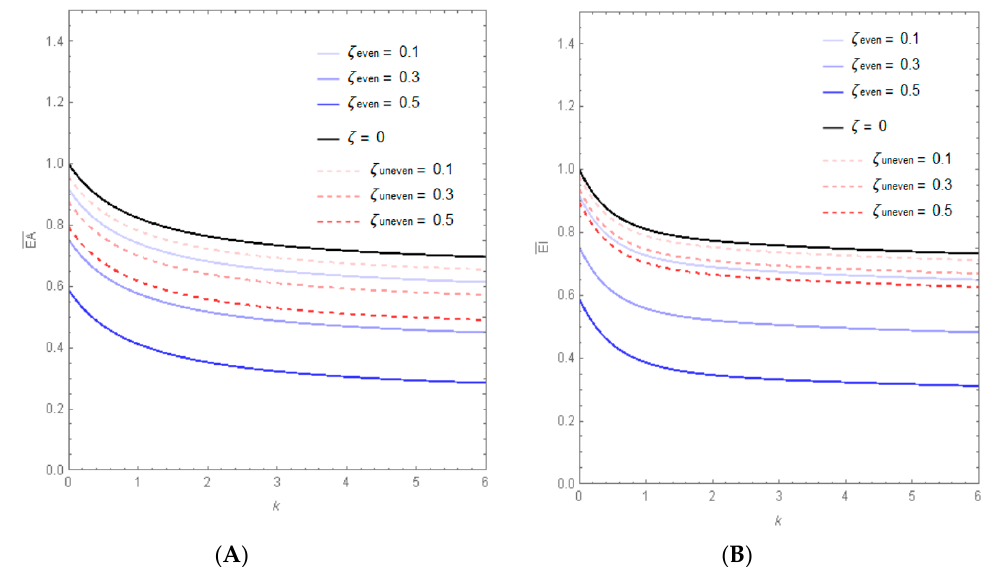
Figure 3. Variations of the dimensionless axial stiffness , 𝐸𝐴(cid:3562) = (cid:3006)(cid:3002) 𝐸𝐼(cid:3562) = (cid:3006)(cid:3010) ( B ). The variations are shown for the porous FG nano-beam in terms of the gradient index of (cid:3006) (cid:3278) (cid:3010) the FG material ( 𝑘 ), varying the porosity volume fraction ( 𝜁 ): even distribution (continuous lines) and uneven distribution (dashed lines).